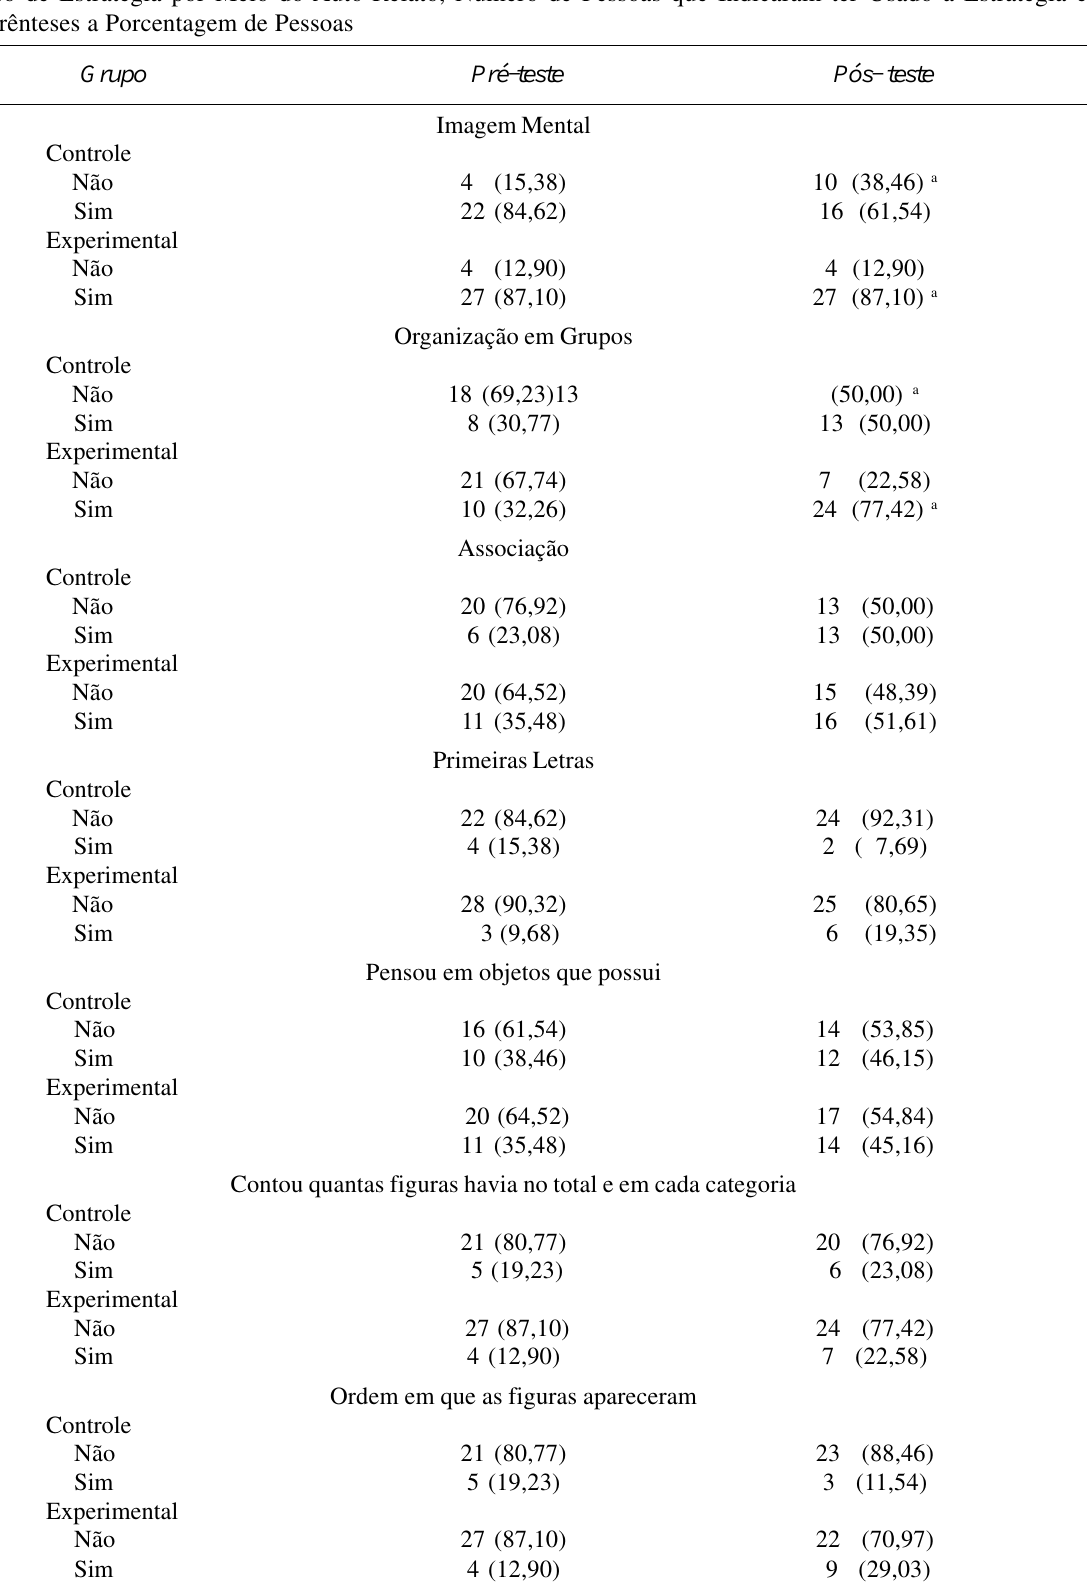
Uso de Estratégia por Meio do Auto-Relato, Número de Pessoas que Indicaram ter Usado a Estratégia e entre parênteses a Porcentagem de